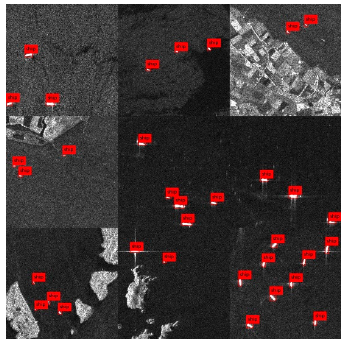
Figure 6. Examples of ship detection in different cases.